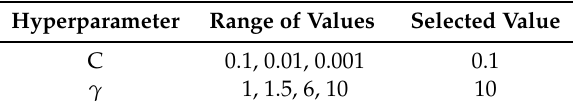
Table 4. SVM hyperparameters selected through